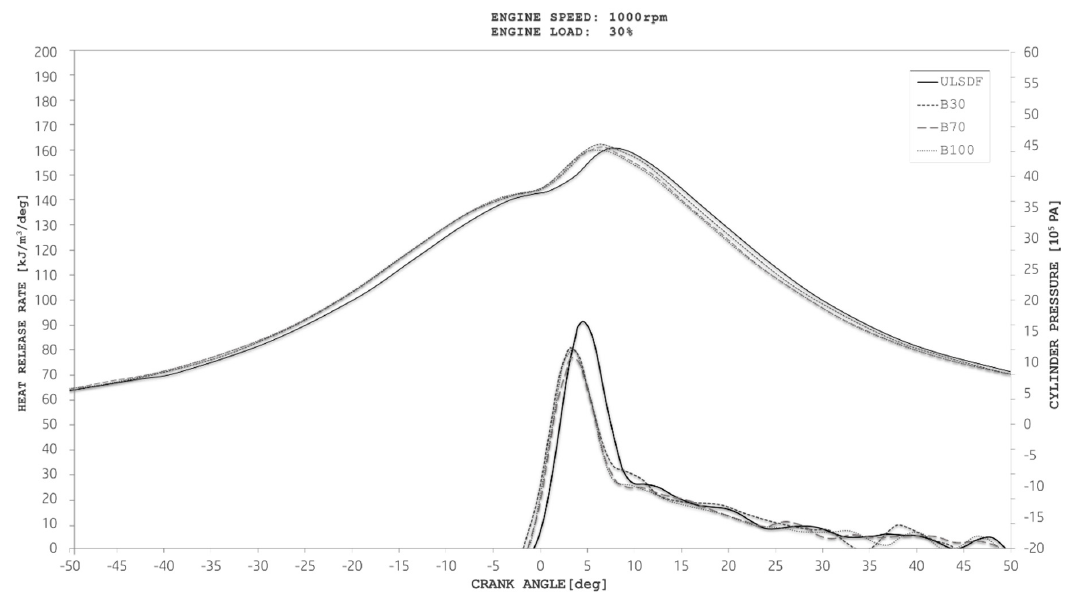
Figure 2. The dependence of fuels on the heat release rate and cylinder pressure (1000 rpm/30%).